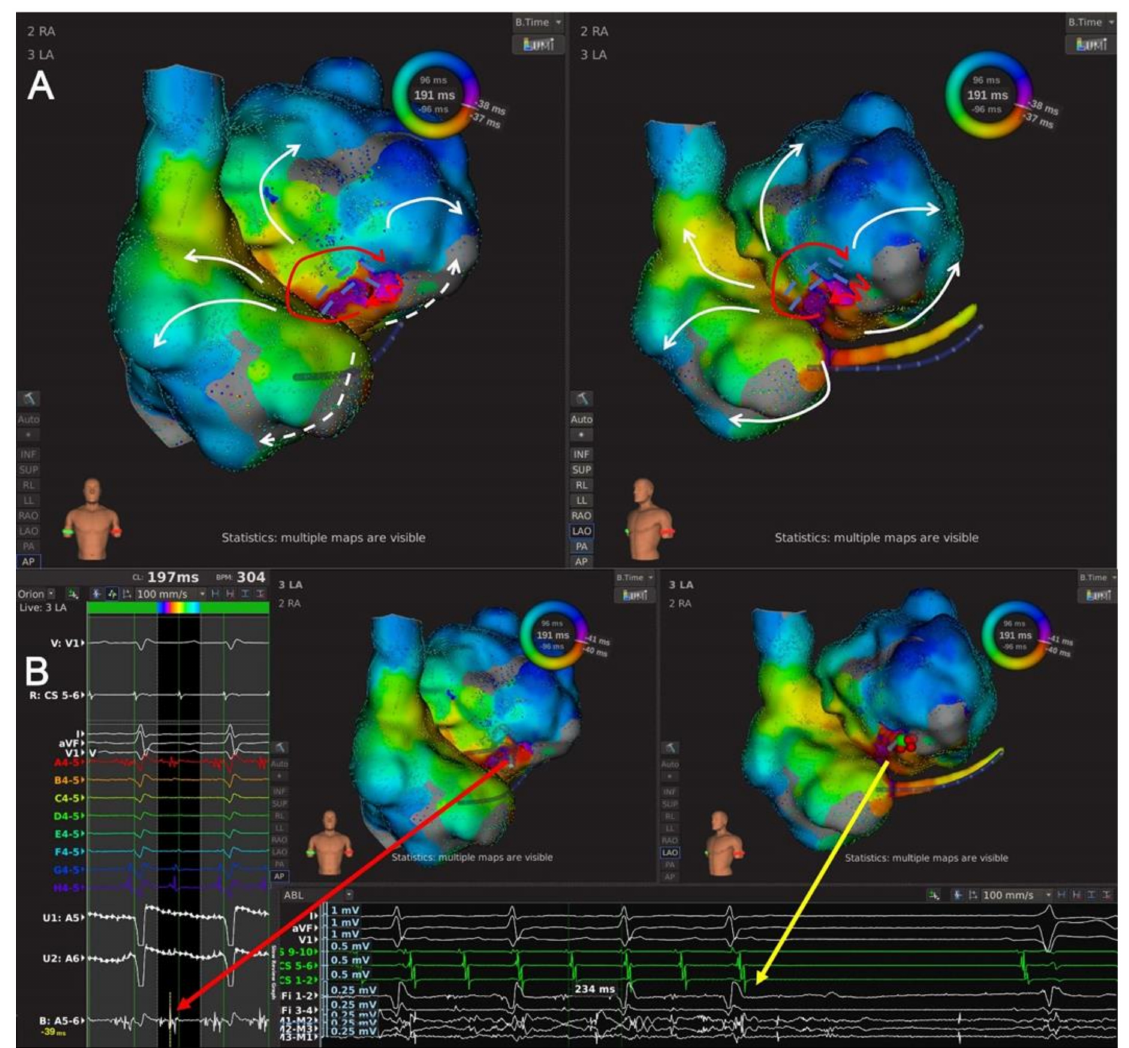
Figure 7. The high-density mapping of a Type 3 AT. ( A ) Activation map of a Type 3 AT from the anteroposterior view (left) and the left-anterior oblique view (right). The high-density mapping identified one minor LAAW block line near the MVA and one LAAW scar. The wavefront ran around the minor LAAW scar and propagated in a centrifugal pattern to activate other part of the LA. The red line with arrows indicated the circuit of AT; the jagged red line indicated the wavefront passing the slow conduction area; the white lines with arrows indicated passive activation; the white dashed lines indicated passive activation behind the atrial structure; the double-dashed blue line indicated a minor LAAW block of line. ( B ) Local map potentials of the LAAW gap during AT (left) and at the moment of AT termination (bottom). The red dots indicated the ablation points; the green dot indicated the termination site; the arrowed red and yellow lines indicated the local potentials during AT and at the moment of AT termination,